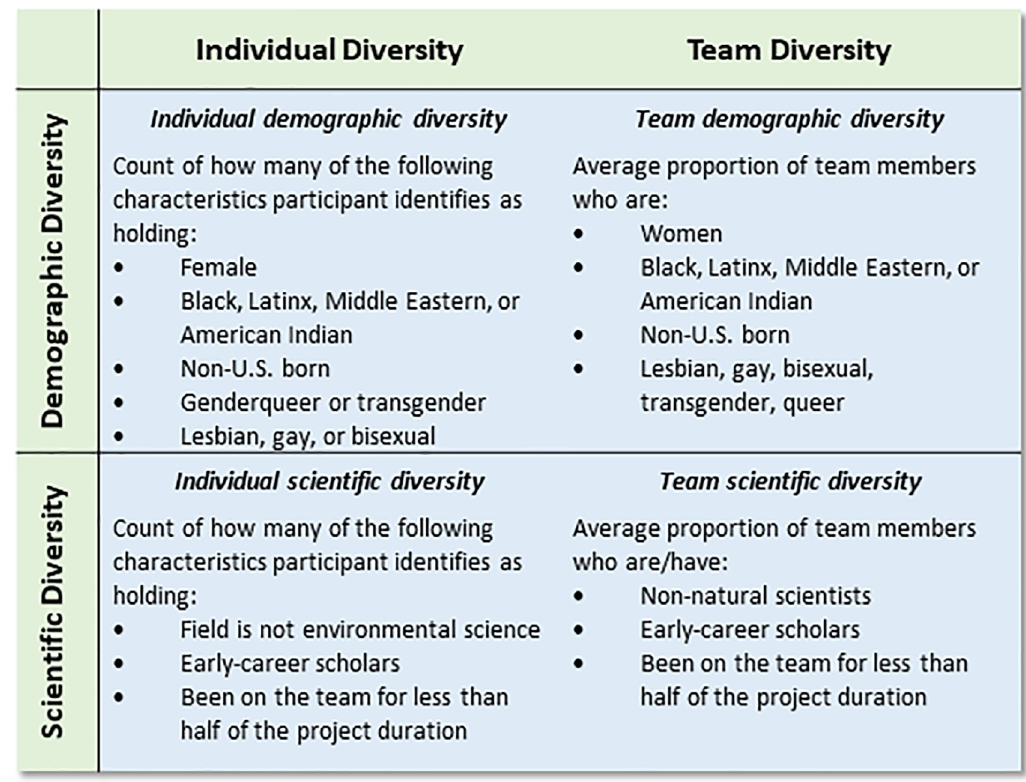
Fig 2. Defining diversity composite variables, both at the individual and team levels based on demographic and scientific